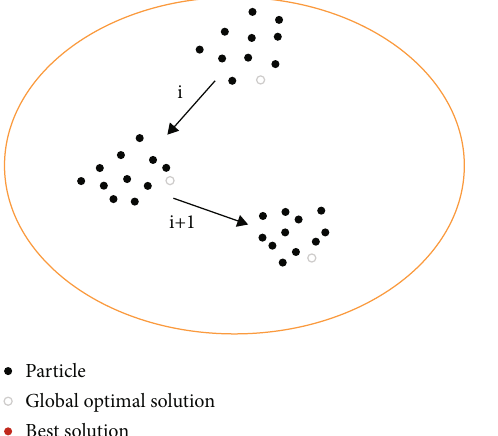
Figure 5: Particle regeneration.